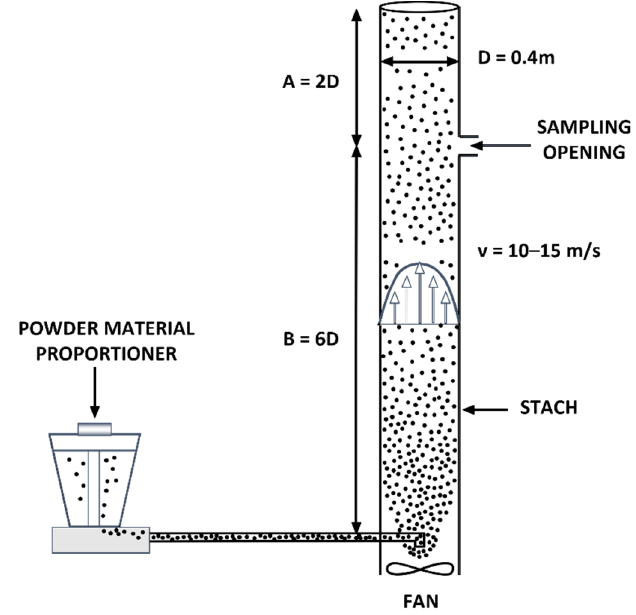
Figure 4. PM emissions generator diagram.